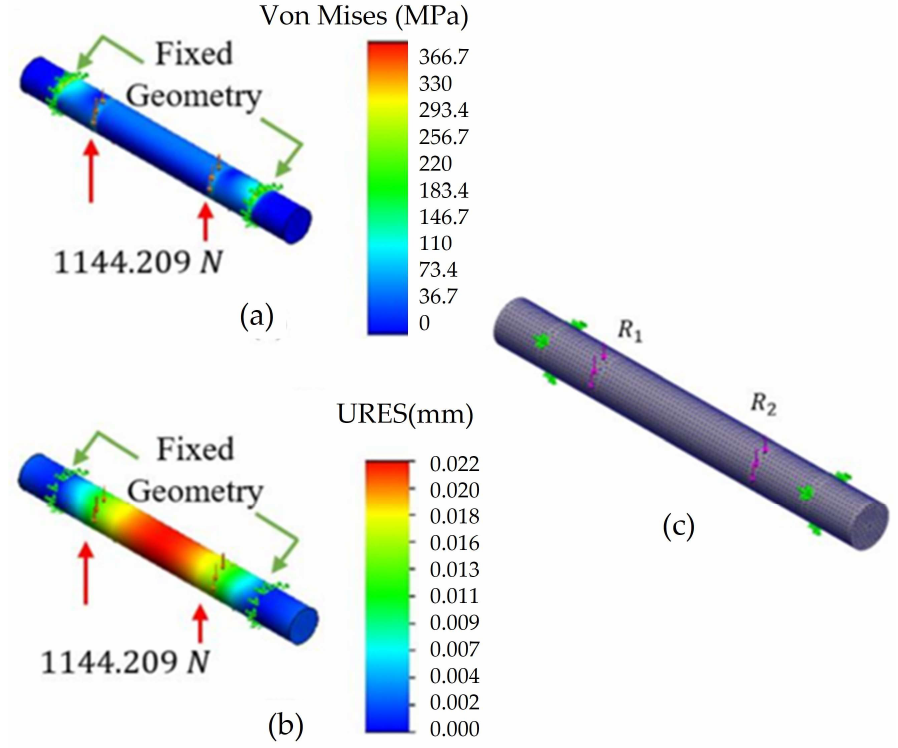
Figure 8. FEM analysis for the ball joint shaft showing where the supports were placed: ( a ) von Mises stress; ( b ) displacement; ( c ) mesh details. stress; ( b ) displacement; ( c ) mesh